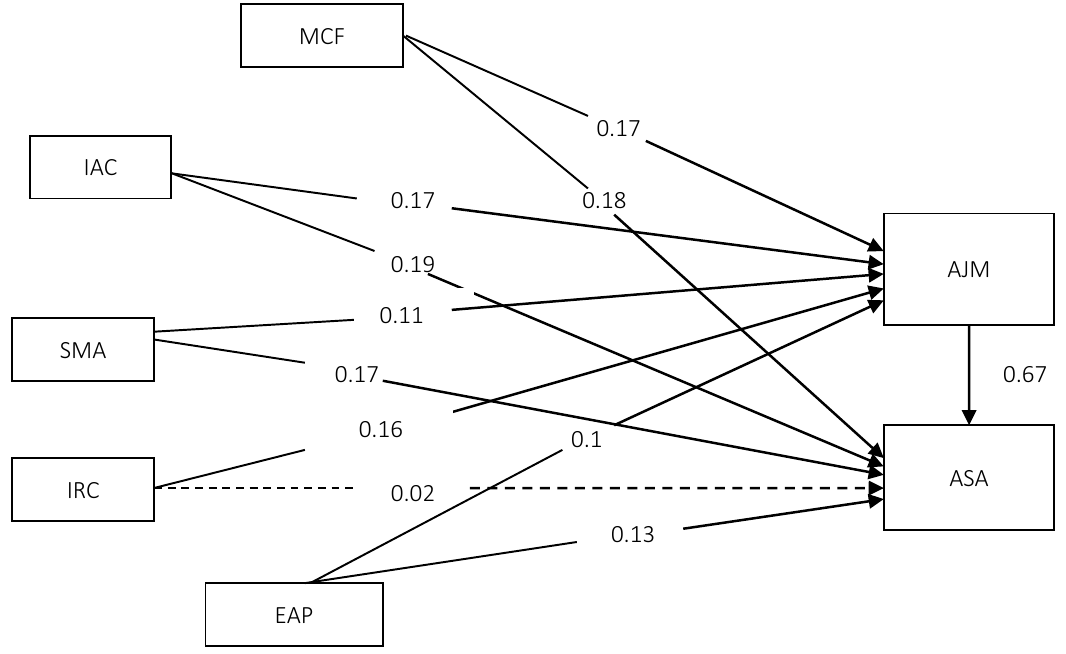
Figure 2. SEM results of the research